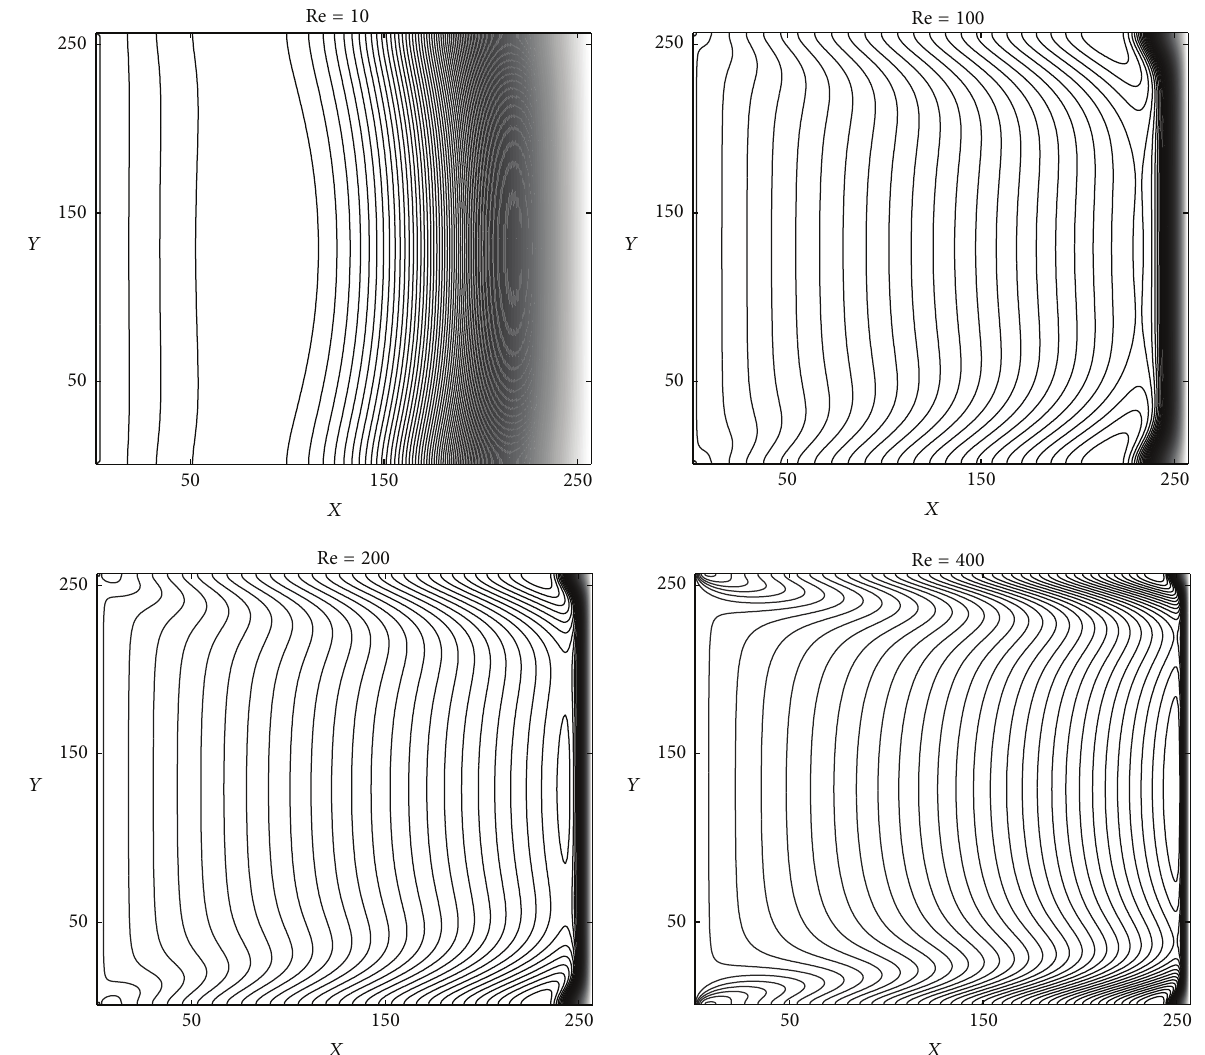
Figure 4: Isothermals for the Reynolds numbers: Re = 10, 100, 200, and 400.